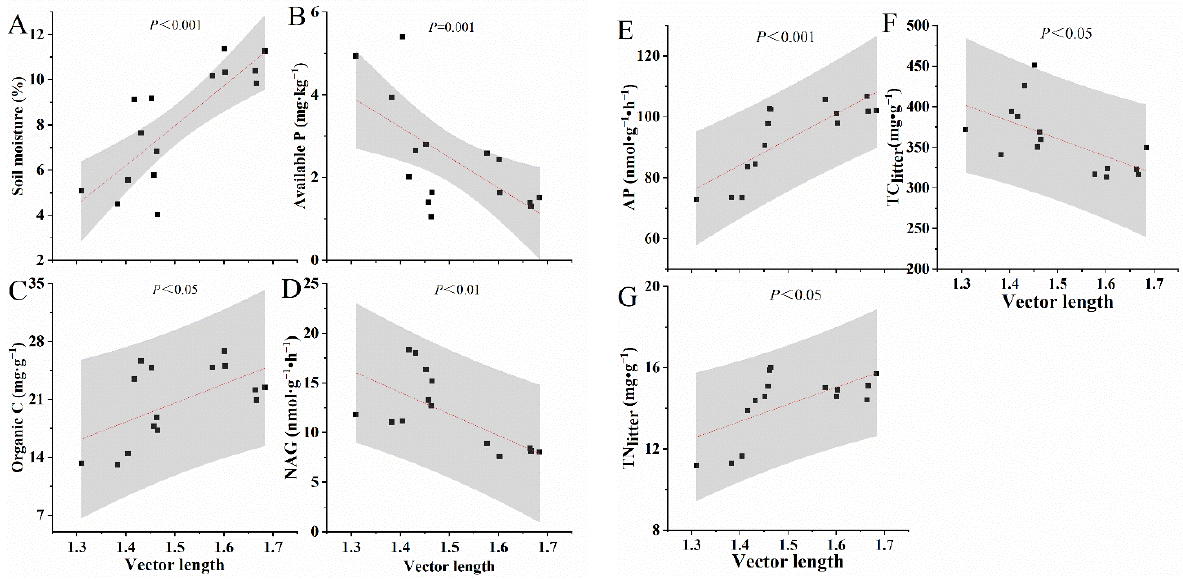
Figure 6. Linear regression analysis between the soil physical properties ( A ), soil nutrients ( B , C ), soil extracellular enzymes ( D , E ), litter nutrients, ( F , G ) and vector lengths. Red lines indicate the model fits between the vector lengths and the properties; grey areas represent the 95% confidence intervals of the models.